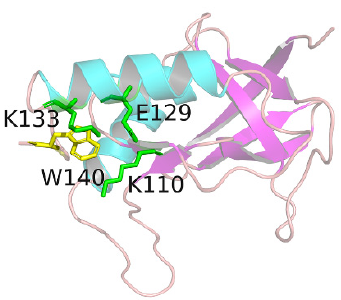
Figure 1. The 3D structure of SNase. W140 is shown in yellow, and the surrounding K110, E129, K133 are shown in green.